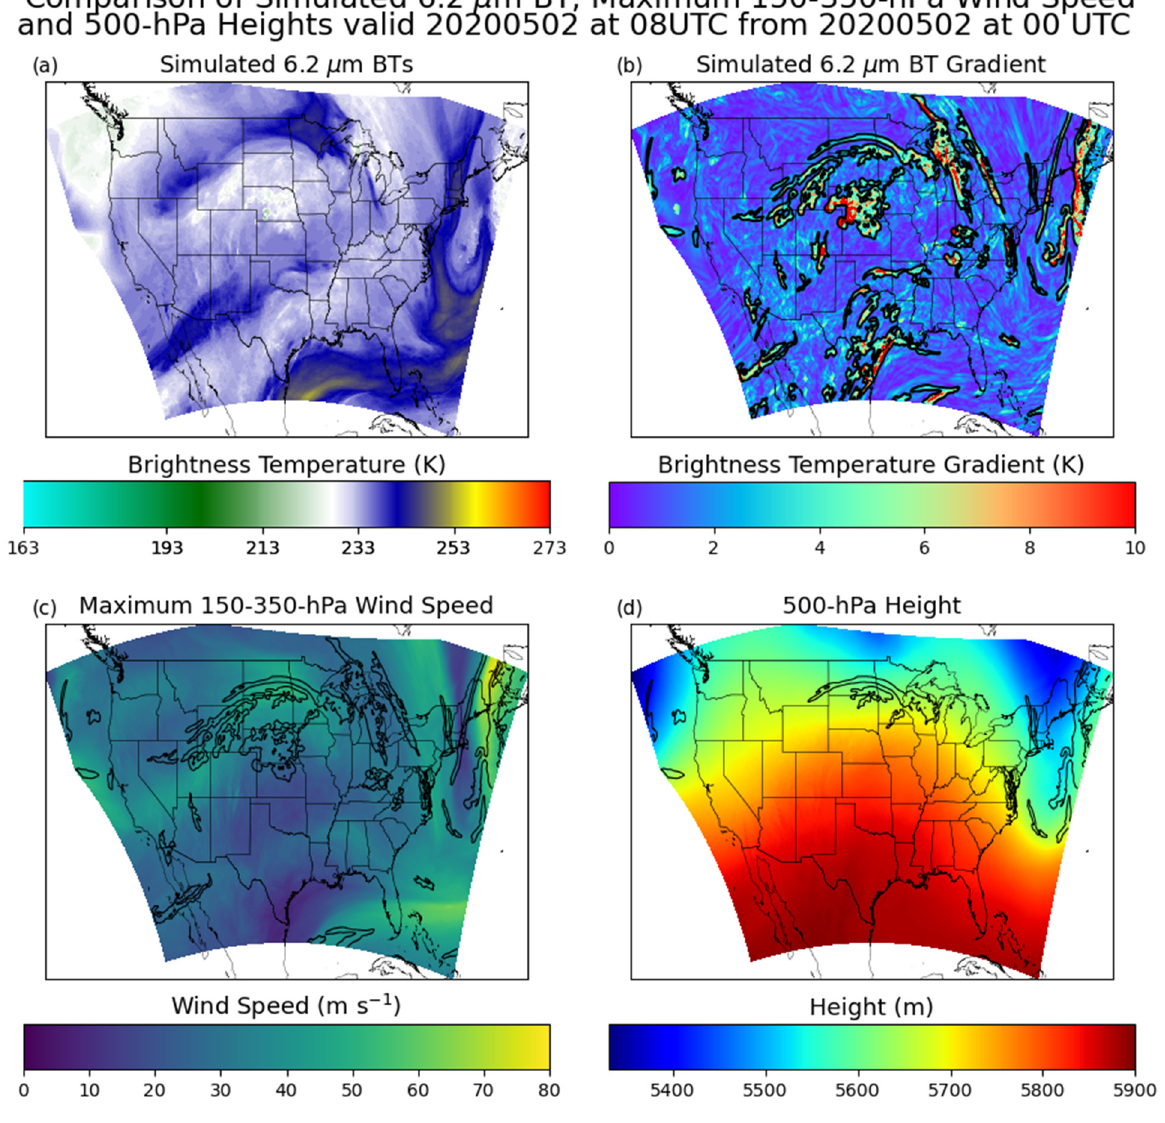
Figure 1. ( a ) Simulated 6.2 μ m BTs, ( b ) 6.2 μ m BT gradients, ( c ) maximum EMC FV3 ‐ LAM wind speed between 150 hPa and 350 hPa, and ( d ) EMC FV3 ‐ LAM 500 hPa heights valid 20200502 at 08 UTC. The black outlined objects in ( b ) indicate MODE objects defined using a BT gradient threshold of 2 K. The black outlined objects in ( c , d ) indicate objects that are co ‐ located with either a jet stream or a trough, respectively.